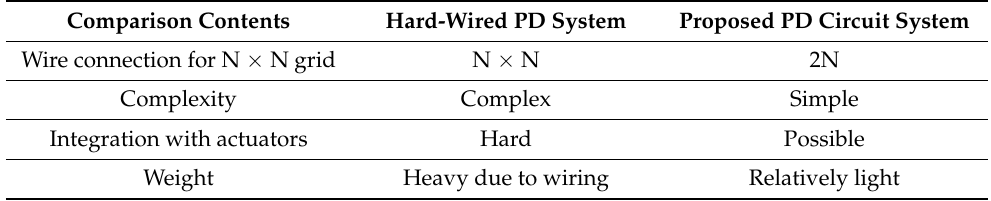
Table 1. Comparison of PD